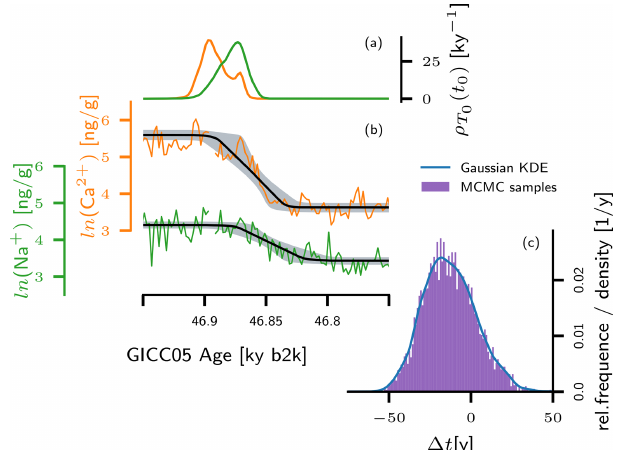
( t 0 ) for the onset Figure 3. (a) Posterior probability distribution ρ T 0 of NGRIP Ca 2 + and Na + transitions associated with the onset of GI-12c, derived from Ca 2 + (orange) and Na + (green) values around the GI-12c onset at 2-year resolution, using the probabilistic ramp- fitting shown in (b) . The black lines in (b) indicate the expected ramp, i.e., the average over all ramps determined by the posterior distributions of the ramp parameters. The grey shaded area indi- cates the 5th–95th percentiles of these ramps. (c) Histogram sam- pled from the posterior distribution for the transition onset lag (cid:49)t between the two proxies (violet), together with the corresponding Gaussian kernel density estimate (KDE,